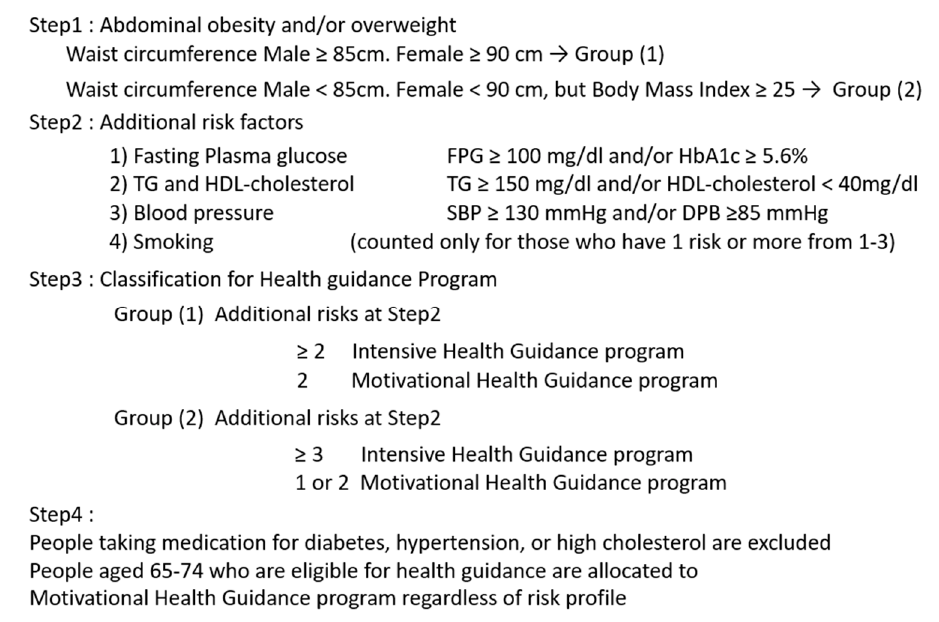
Figure 5. Participant classification for the Health Guidance program by the Ministry of Health, Labor, and Welfare in Japan [40].